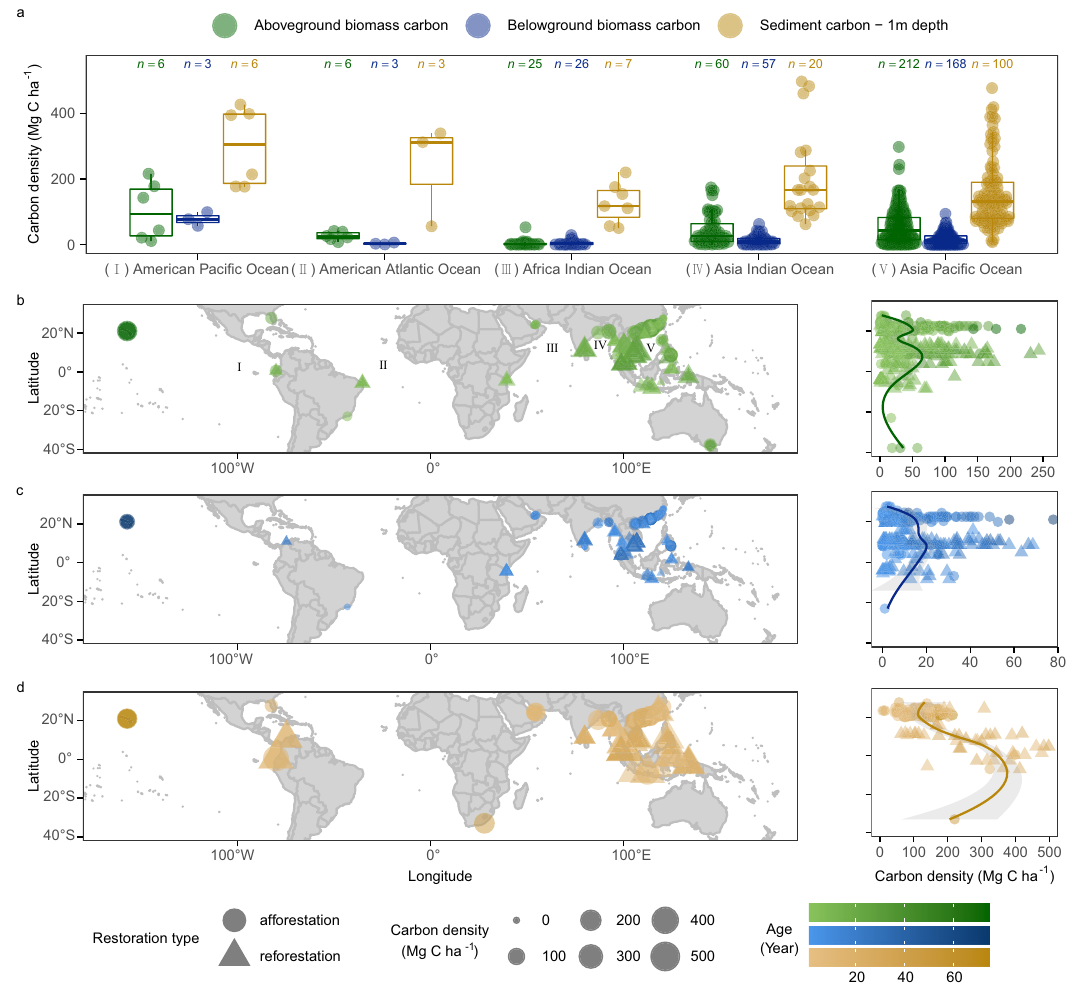
Fig. 1 | Carbon density among global mangrove ecosystem restoration pro- jects. Colors represent different carbon pools (green: aboveground biomass car- bon; blue: belowground biomass carbon; brown: sediment carbon to 1m depth). a Carbon density distribution of the three carbon pools for mangrove ecosystem restoration projects by geography. For each box plot, individual data points are shown as circles. The center line and the top and bottom of the box represent the median and the interquartile range (25th percentile and 75th percentile). The whiskersrepresent the minimum and maximum limits. The sample size ( n ) ofeach